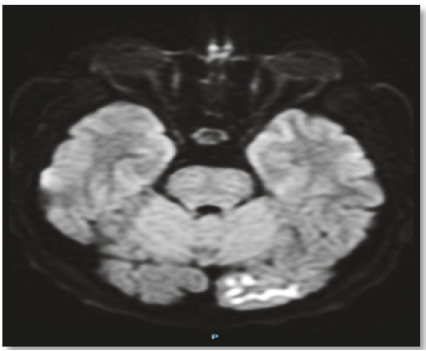
Figure 2: Periictal brain MRI DWI showing gyriform hyperintense signal over the left occipital cortex. Abbreviations: DWI, diffusion- weighted image; MRI, magnetic resonance imaging.